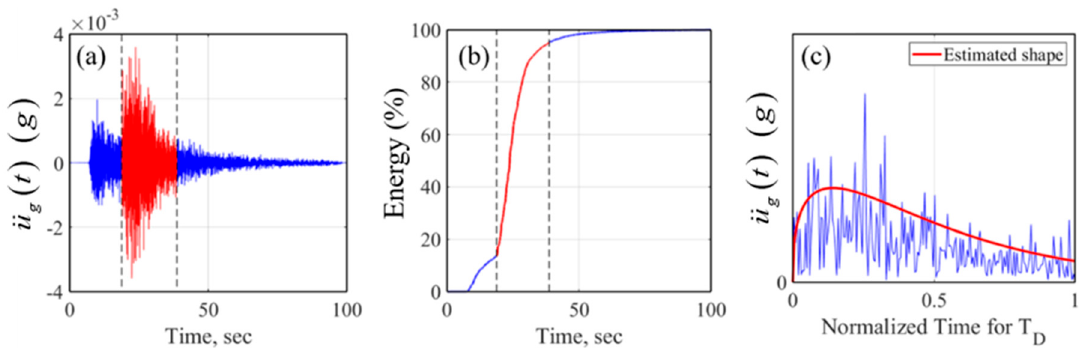
Figure 10. Estimated shaping window and duration at the BUS2 station for the 2017 Pohang earthquake: (a) Ground motion acceleration, (b) Normalized arias intensity, (c) Shaping window.